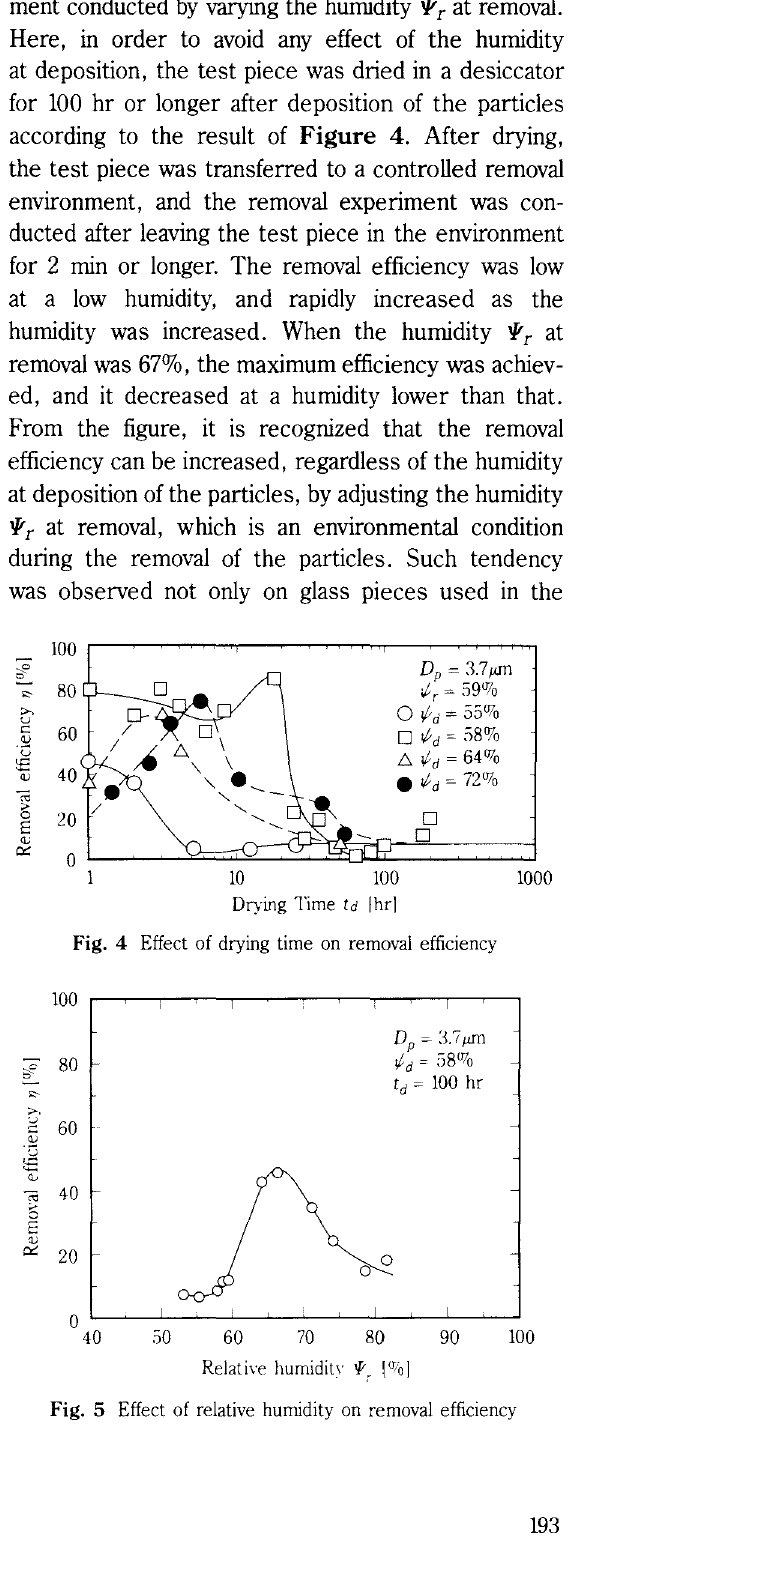
Fig. 4 Effect of drying time on removal efficiency